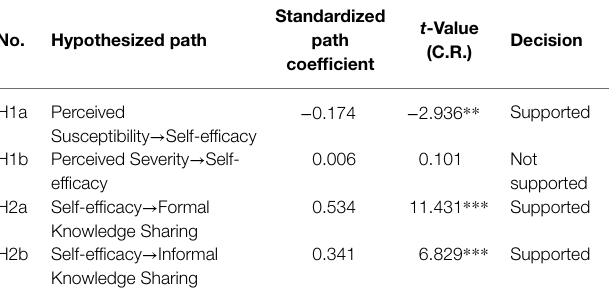
TABLE 5 | Hypotheses testing results.